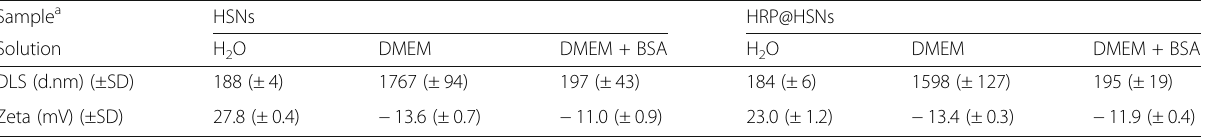
Table 1 Dynamic light scattering (DLS) and zeta potentials of nanoparticles in water, Dulbecco ’ s modified Eagle ’ s medium (DMEM), and DMEM + bovine serum albumin (BSA)